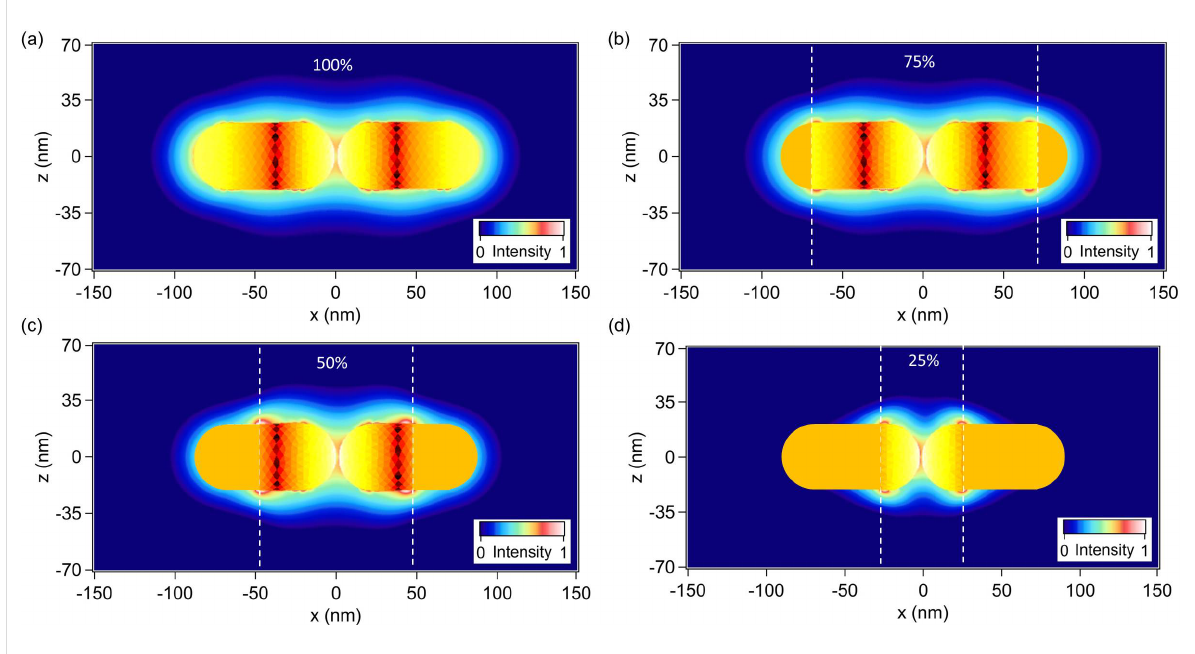
Figure 5b. Removing the nonlinear polarization at the